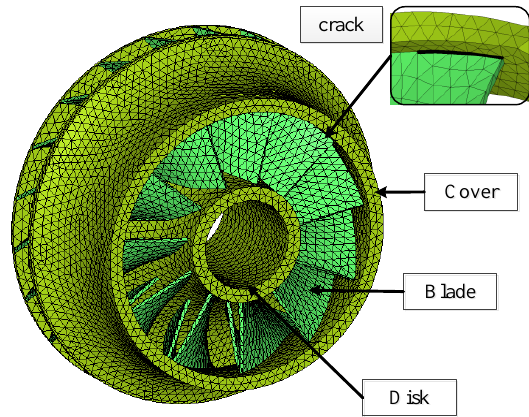
Figure 24. Finite element model of an impeller and a sector model.